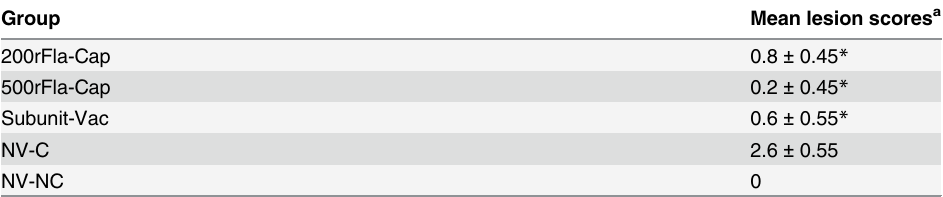
a Asterisks ( * ) within columns represent signi fi cantly difference of mean lesion scores between the rFla- Cap- or Subunit-Vac-vaccinated and non-vaccinated PCV2-challenged pigs after challenge ( P < 0.05). The data show the mean scores of fi ve pigs in each group from one of two independent